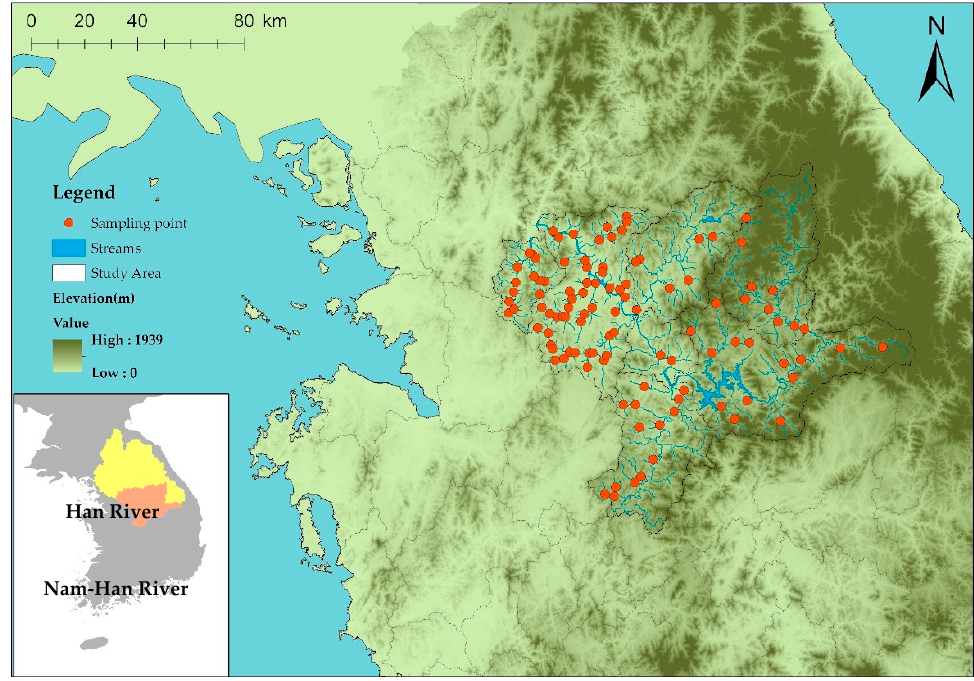
Figure 1. Sampling sites in the Nam-Han River Basin in Korea selected by the National Aquatic Ecological Monitoring Program.